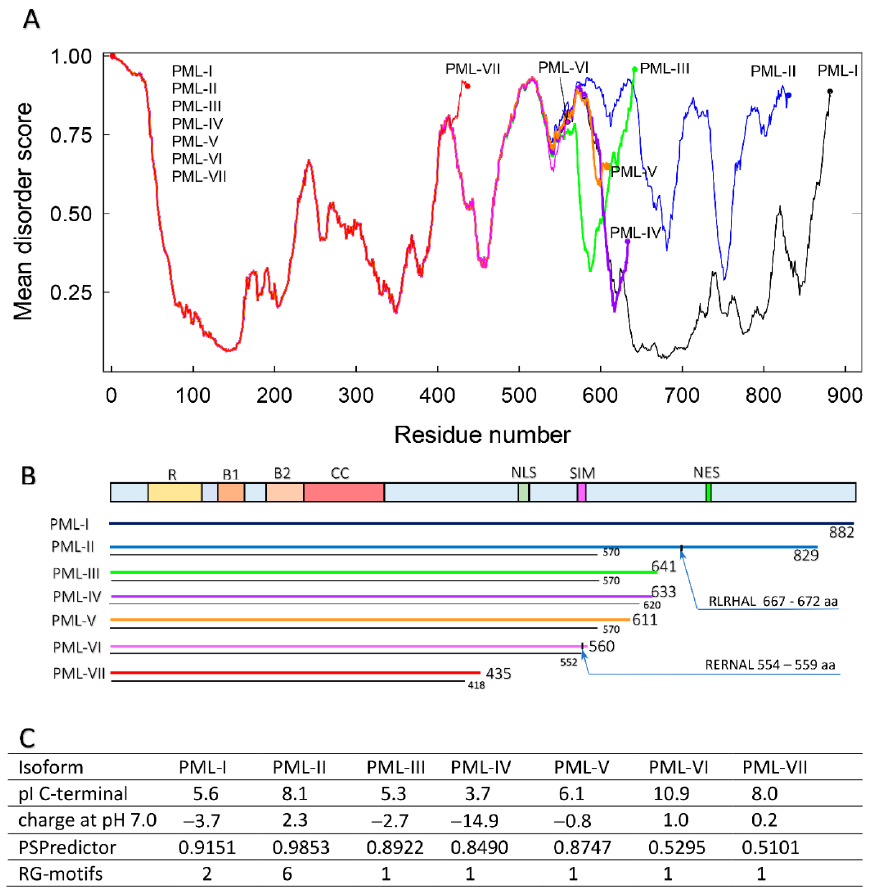
Figure 1. Schematic presentation of different alternatively spliced isoforms of human PML protein. ( A ) Mean disorder score. Disorder score determined by s(MDP), IUP2(S), IUP2(L), VLXT, VL3, VSL2B, PONDR-FIT algorithms are presented in Figure 1. ( B ) The generalized domain structure, indicating positions of the Ring domain (R — amino-acid residues 45 – 105), Box 1 (B1 — residues 124 – 166), Box 2 (B2 — residues 184 – 230), Coil-coil (CC — residues 229 – 323), Positions of the nuclear localization signal (NLS — residues 476 – 490), SUMO-interacting motif (SIM — residues 556 – 562) and nuclear export signal (NES — residues ~704 – 713, exclusive to isoform I). Double lines show the length of each isoform (colored line) and the length of the fragment in which the amino acid residues are the same in PML-I isoforms. Arrows indicate the position of membrane binding domains (667 – 672 a.a. in PML-II and 554 a.a. in PML-VI). ( C ) Different characteristics of PML-isoforms: pI of C-terminal domain, the charge of protein at pH 7.0, the result of LLPS prediction analysis, the content of RG-motifs in amino acid sequence.